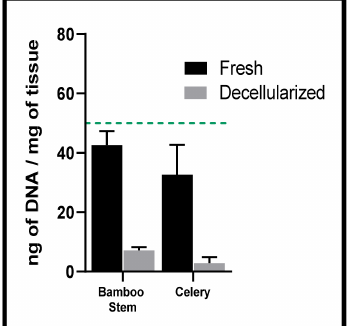
Figure 2. Green dashed line indicates current proposed quantitative threshold for decellularized animal tissues to be 50 ng of DNA/mg of tissue. Native plant materials such as lucky bamboo stems or celery stalks naturally fall below this level; standards should be modified to be more conducive to the extensive plant kingdom. Data generated by authors for illustrative purposes for this